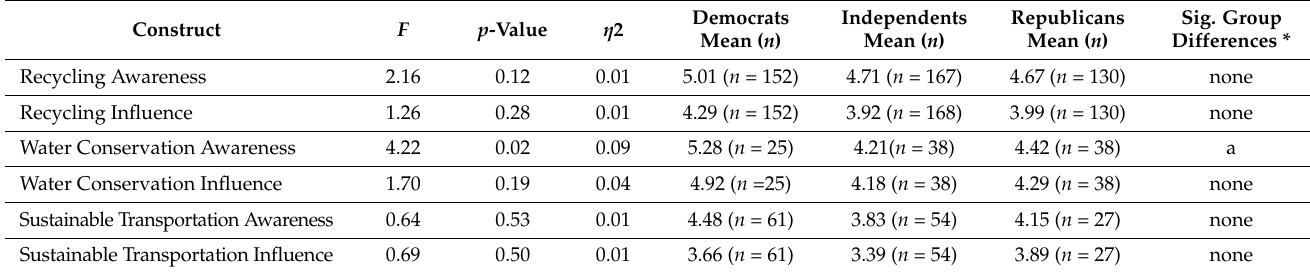
Table 3. ANOVA—Awareness and Influence of Sustainability Initiatives Based on Political Party.